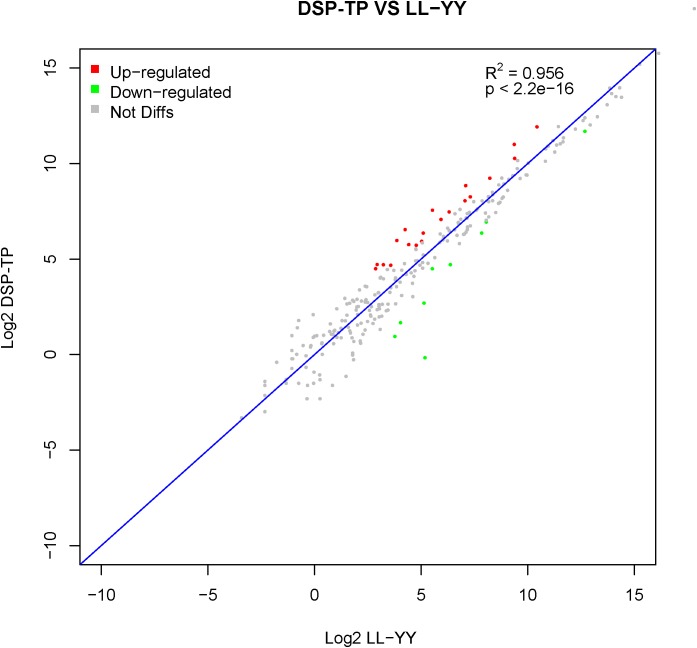
Comparison of transcript expression levels between Diannan Small-ear pig-Tibetan pig (DSP-TP) and Landrace-Yorkshire (LL-YY) groups.The vertical axis represents the Log2 fragments per kilobase of exon per million fragments mapped (FPKM) in the DSP-TP and the horizontal axis represents the Log2 FPKM in the LL-YY. Differentially expressed (DE) miRNAs were filtered using P ≤0.01 and |log2ratio| ≥1 as a threshold. The red points represent upregulated miRNAs, and the green points indicate downregulated miRNAs. The gray spots represent no significant differences between the DSP-TP and LL-YY samples.